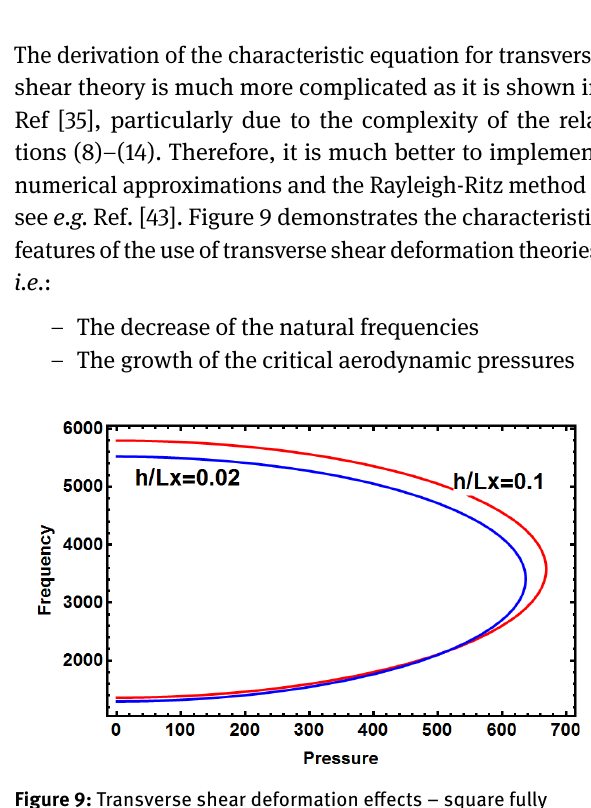
Figure 9: Transverse shear deformation effects – square fully clamped